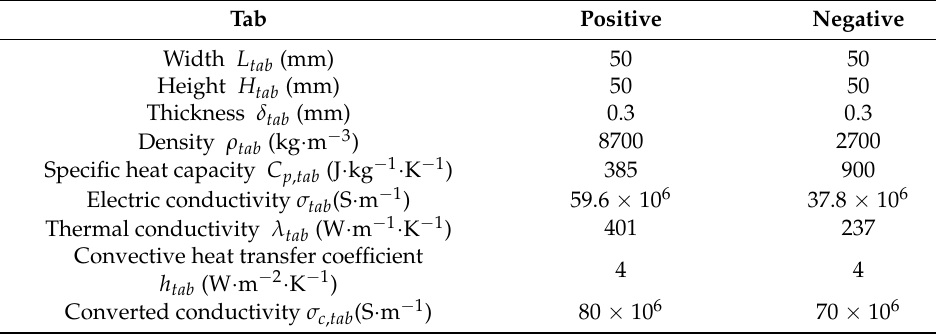
Table 5. Material parameters of the tabs